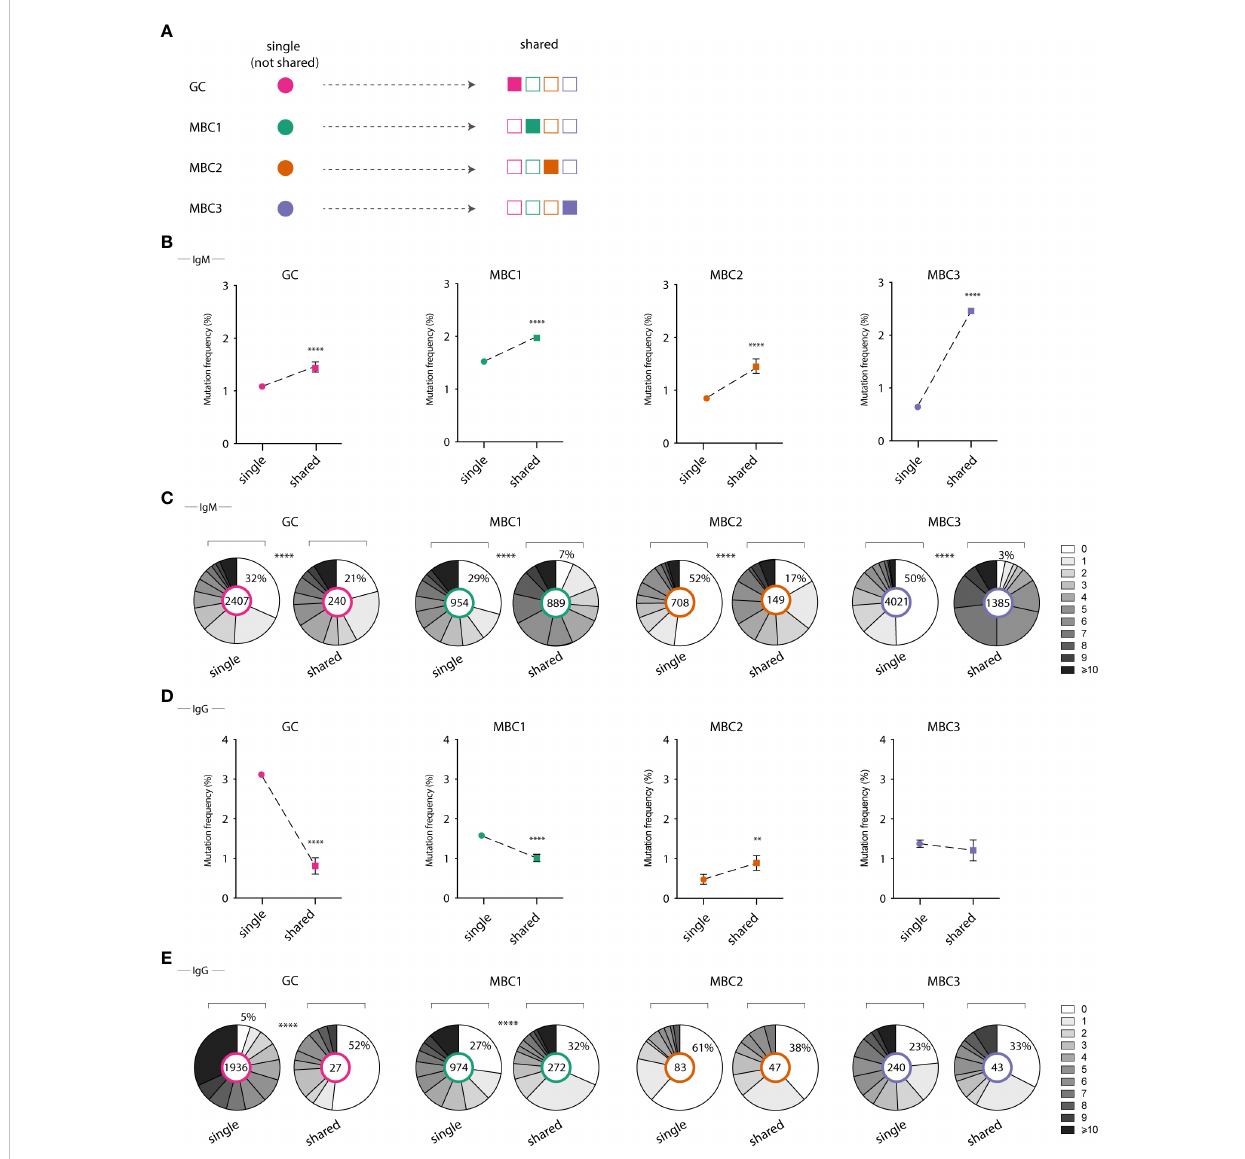
FIGURE 5 Mutation frequency in single vs shared clones in GC B cells and MBC subsets. (A) Illustrative graph shows de fi nition of single and shared H-CDR3s (B, D) Graphs show mutation frequency in single and shared H-CDR3s for IgM sequences (B) and IgG sequences (D) . (C, E) Pie chart shows the number of mutations in single vs shared H-CDR3s for IgM sequences (C) and IgG sequences (E) . Results from a pool of 6 mice. **P<0.01;